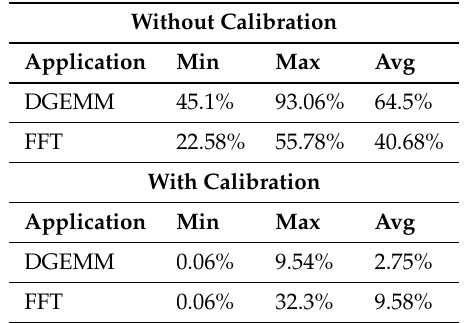
Table 5. Percentage error of dynamic energy consumption with and without calibration and HCLWattsUp on Intel Xeon Phi